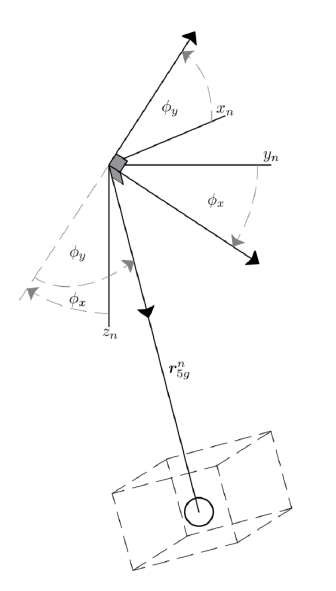
Figure 8: Euler angles, φ x and φ y , representation of the orientation of the pendulum